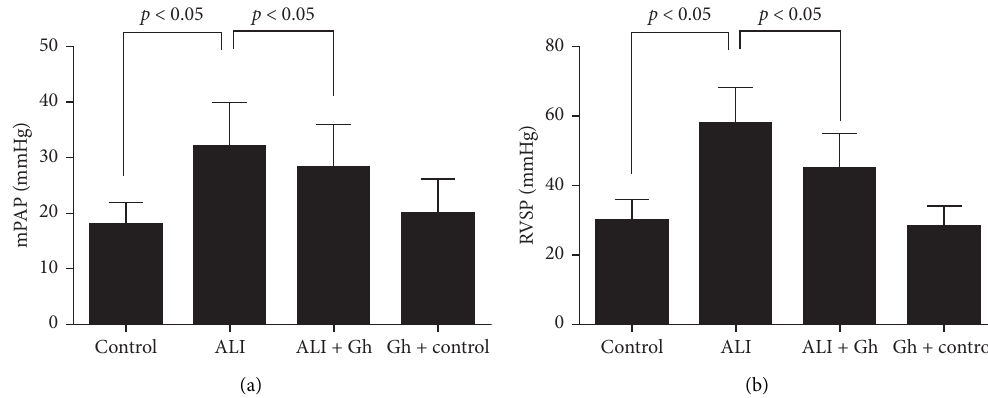
Figure 1: Ghrelin pretreatment reduced the mean pulmonary arterial pressure (mPAP) and right ventricular systolic pressure (RVSP) of LPS-induced ALI rats. (a) The mean mPAP and (b) RVSP were measured at 4h after the LPS challenge (5mg/kg). Data are presented as the mean ± SD ( n � 4–6).